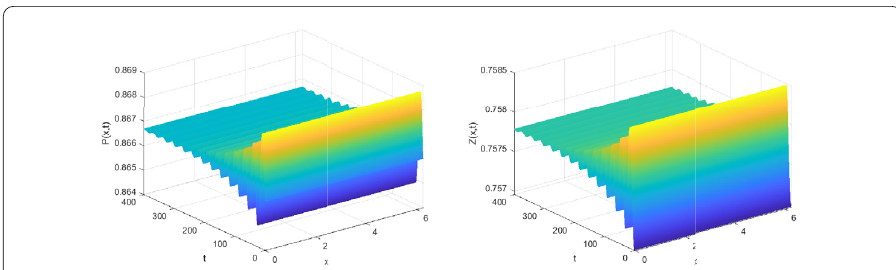
Figure 3 If τ = 2, the equilibrium E ∗ = (0.866,0.757) is locally asymptotically stable